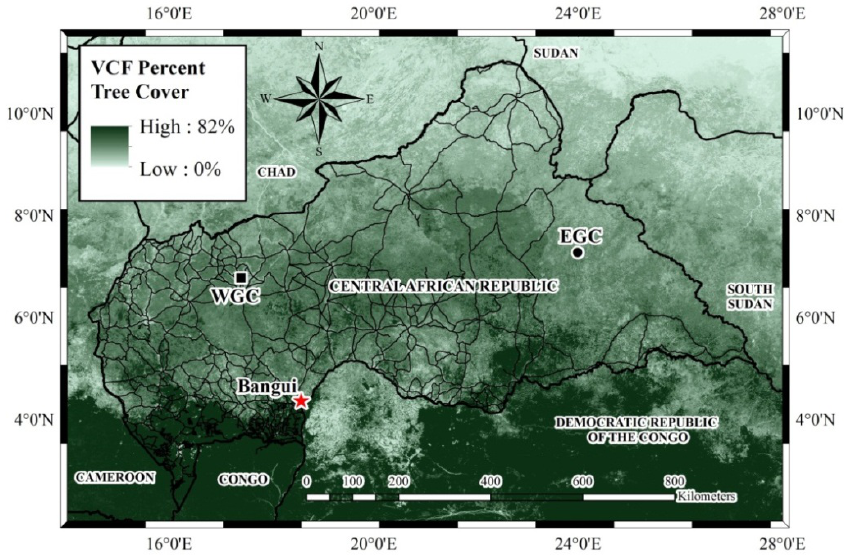
Figure 1. Map of the Central African Republic (CAR) showing: (i) major road networks; (ii) locations of the western and eastern grid cells (labeled WGC and EGC) used to demonstrate two example fire seasons in Figure 2; and (iii) percent tree cover characterized according to the 500 m Global Land Cover Facility (GLCF) Version 3 of the Collection 4 Vegetation Continuous Field (VCF)